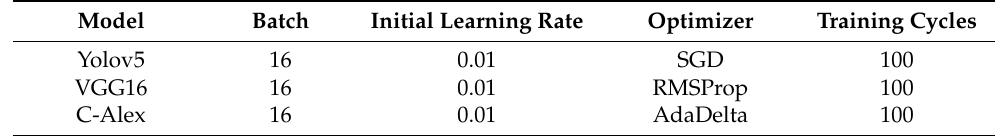
Table 1. Hyper parameter settings for the first part of the study